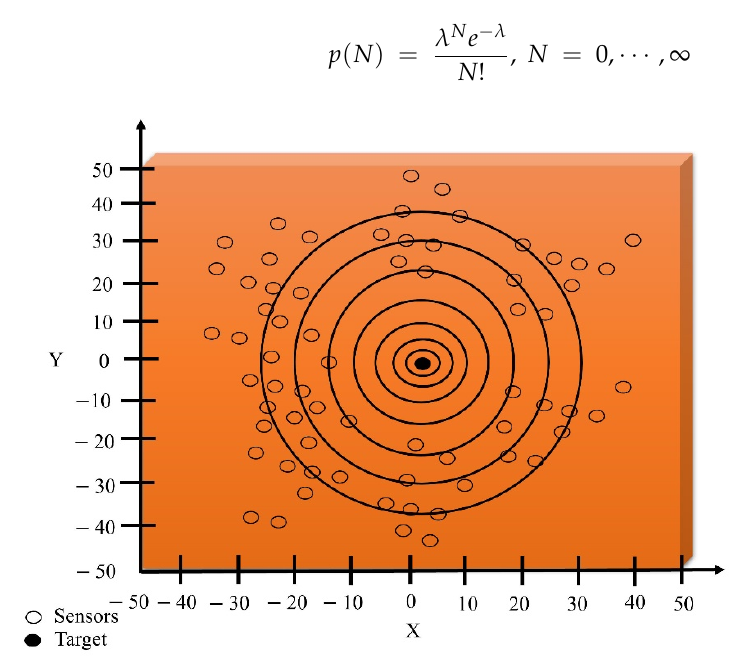
Figure 19. Signal energy contours for targets located in the sensor area.